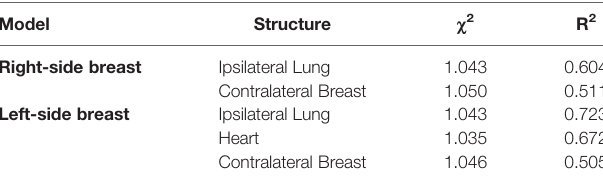
TABLE 1 | Final model goodness parameter for models for both right and left sided breast cancer